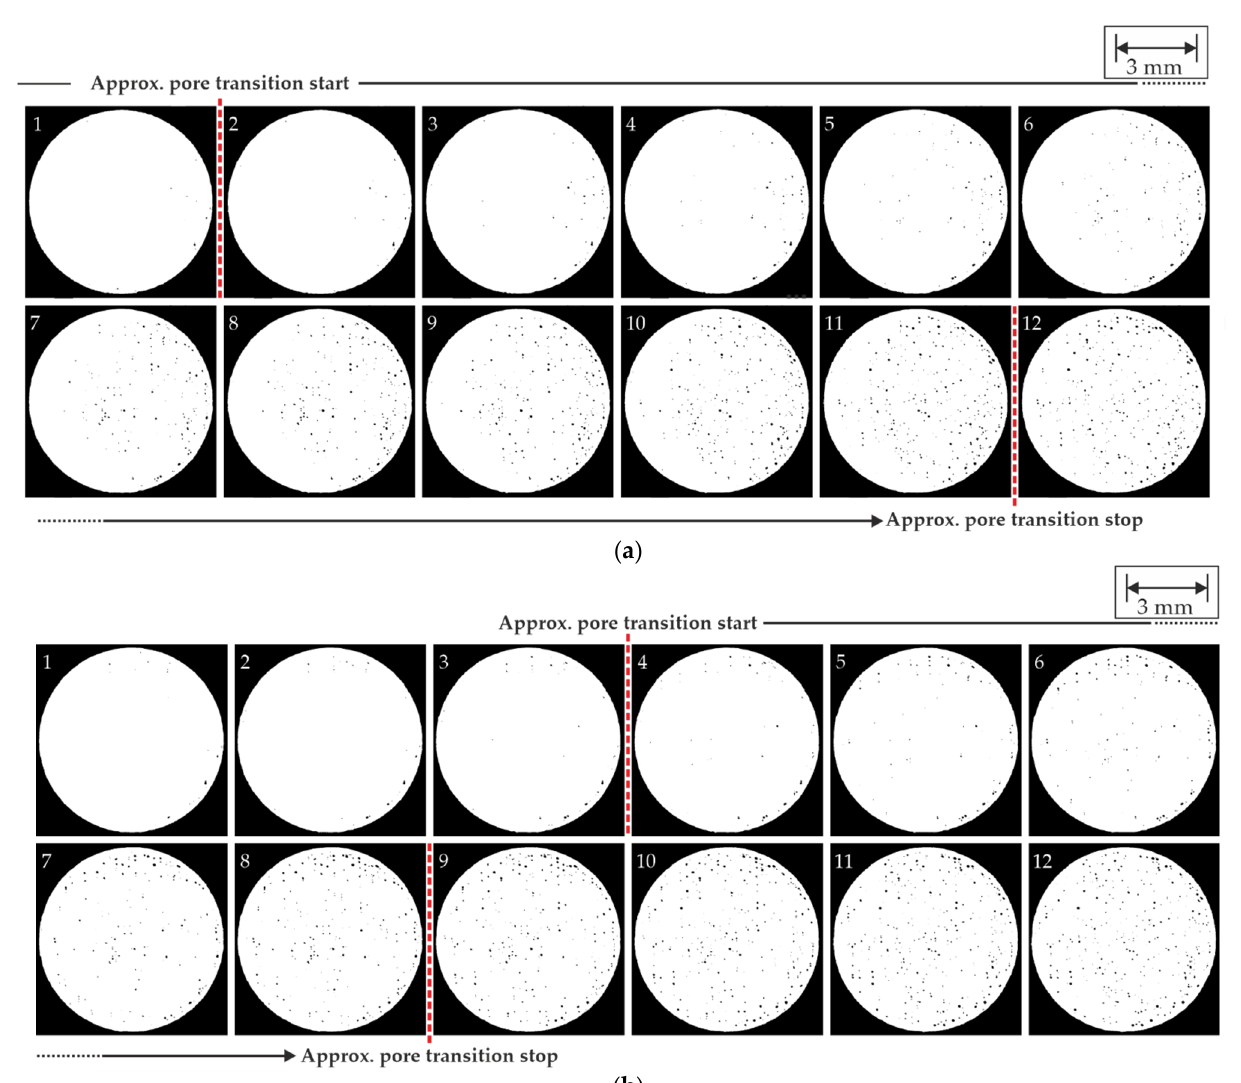
Figure 7. Pore distribution between section 5 and 6 starting at a specimen height of approximately 1050 voxels (10.5 mm) increasing by z’ = 1 voxel (10 μ m) per image slice ( a ) before deformation adjustment ( V proc,bin ) and ( b ) after deformation adjustment ( V final ). While the pore appearance in ( a ) is mainly starting on the right specimen half and transitions over the course of 10 image slices to the left half, the pore appearance in ( b ) begins mainly in the center and transitions faster (approximately in 5 image slices) from singular pores to a widespread distribution over the entire cross-section. The dashed red lines indicate the approximate starting and stopping points of the pore transition and are added to increase the readability of the figure. The starting points were manually approximated based on the appearance of a sufficient number of clearly identifiable pores in the cylinder bulk. The stopping points were manually approximated as the images in which pores appeared in major parts of the bulk.